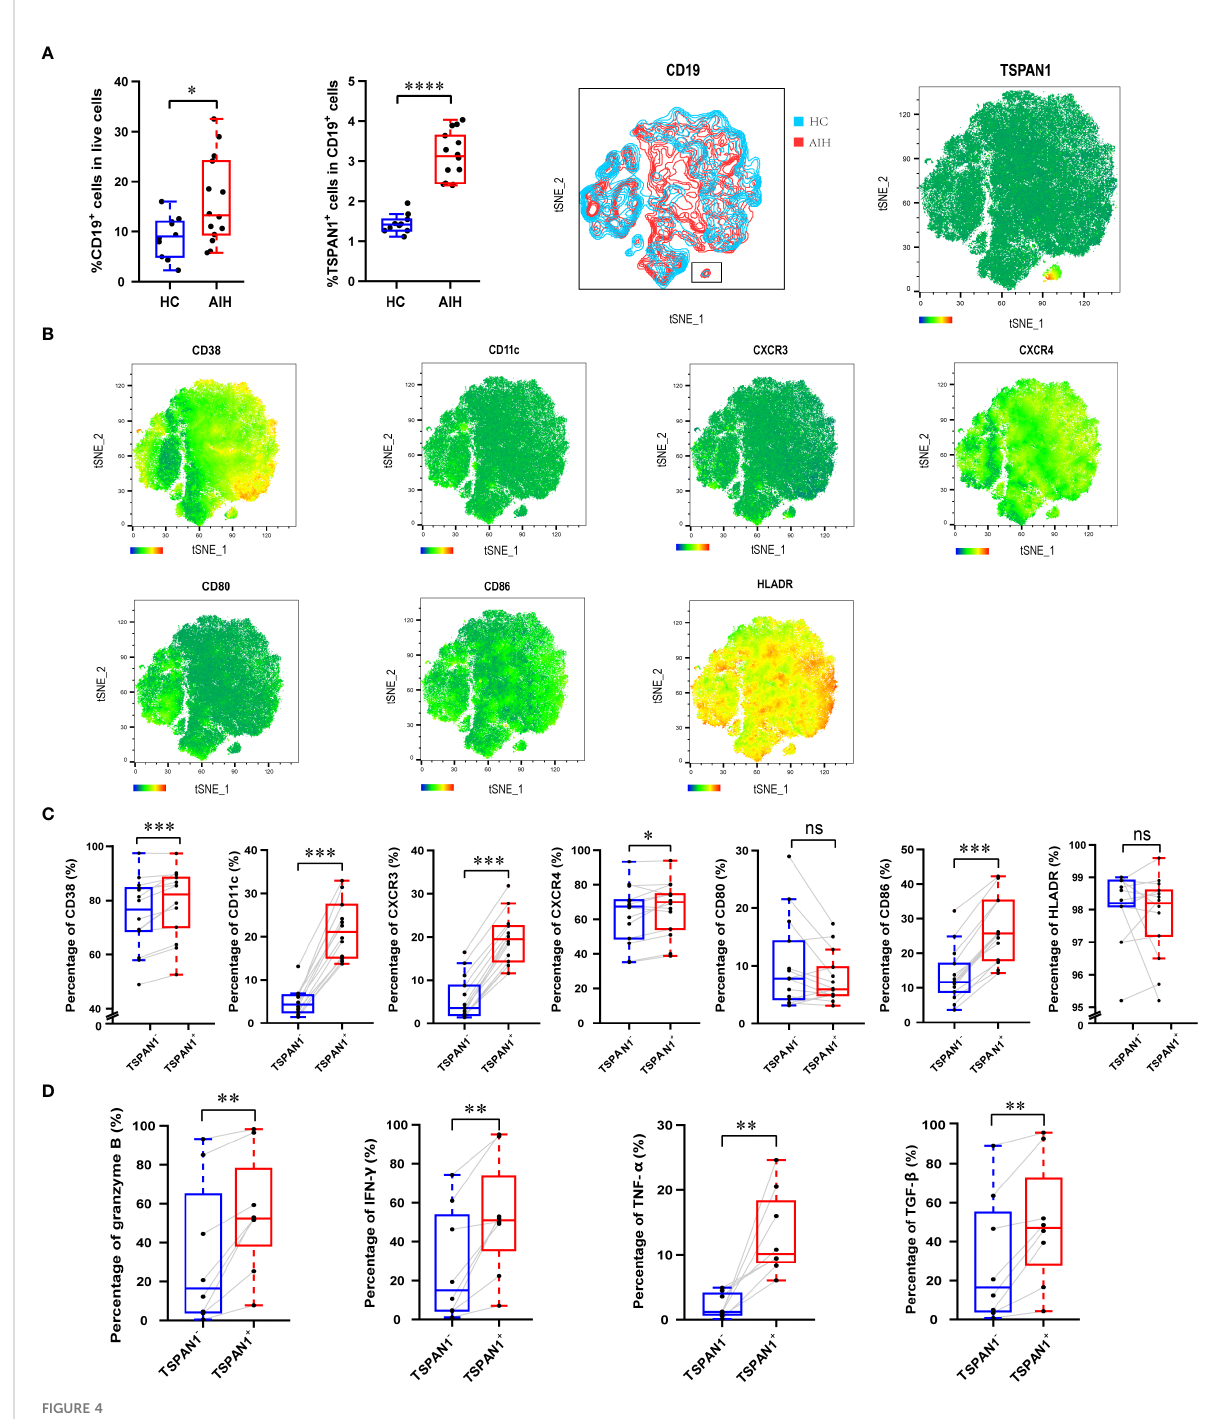
FIGURE 4 The immunological characteristics of TSPAN1 + cells in AIH. (A) The percentage of CD19 + B cells and TSPAN1 + cells in peripheral blood mononuclear cells were elevated in AIH patients (n = 14) compared with HCs (n = 10). By t -SNE analysis of CD19 + B cells, the TSPAN1 + cell subset was compared between HC and AIH indicated by the black rectangle (left), and TSPAN1 expression in CD19 + B cells was shown in AIH (right). (B) Expression of surface markers was shown by t -SNE analysis of CD19 + B cells from AIH patients. Color is based on the expression of certain markers. (C) Analysis of surface markers in paired TSPAN1 - cells and TSPAN1 + CD19 + cells from patients with AIH. Wilcoxon matched- pairs test was used. (D) Expression of cytokines in paired TSPAN1 - cells and TSPAN1 + CD19 + cells from patients. * P < 0.05, ** P < 0.01, *** P < 0.001, **** P < 0.0001, ns: no signi fi